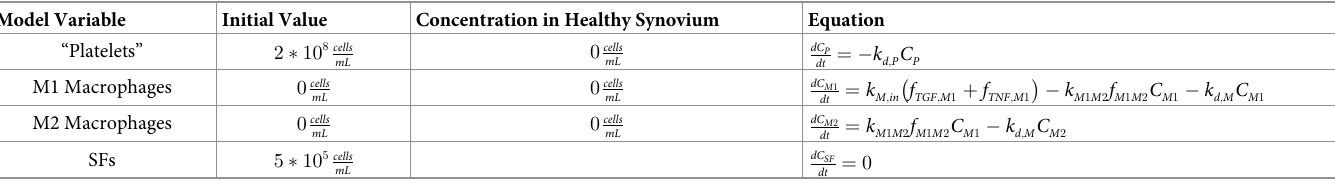
Table 1. Equations for cellular